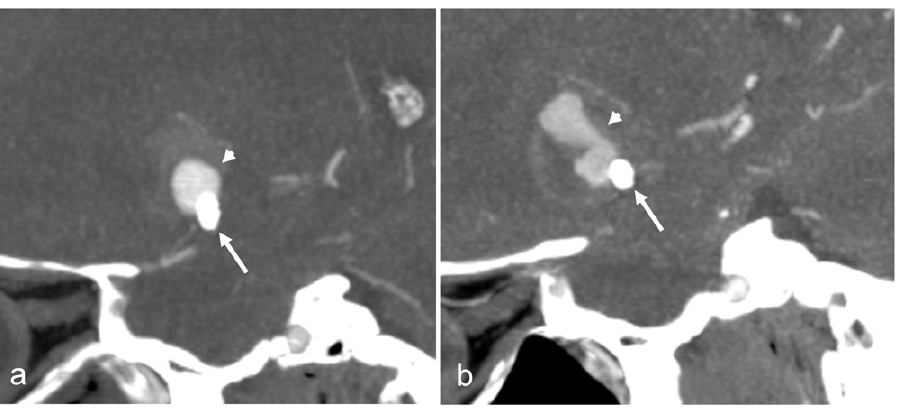
Figure 2. Partially thrombosed aneurysm after treatment with the flow diverter. CT angiograms showing a residual lumen within a large partially thrombosed fusiform aneurysm of the middle cerebral artery. Follow-up CTA (a) was performed 4 months and (b) 6 months after SFD (arrows) placement. The second follow-up study shows enlargement of the residual aneurysm lumen (arrow heads) and was performed after a new haemorrhage (not shown).